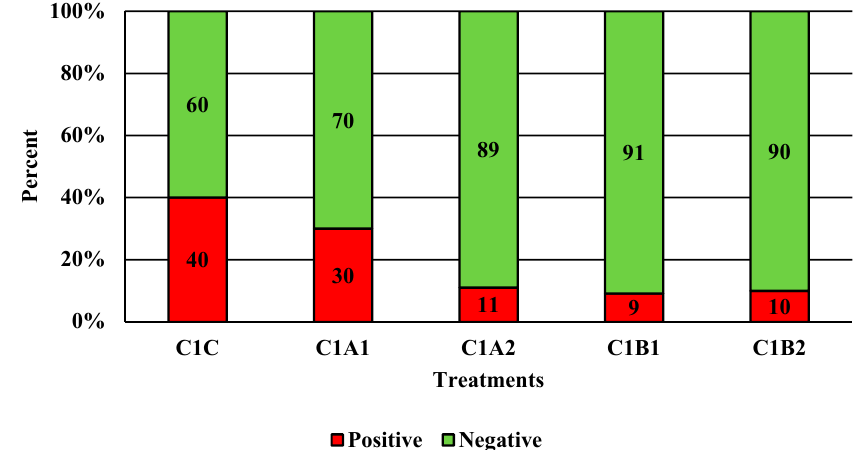
Figure 5. The effect of Competitor 1, a PAA sanitizer used as an antimicrobial dip (400 or 600 ppm) and in a stationary chilling tank (25 or 45 ppm) on the prevalence of Campylobacter present in the rinsates of 42-d-old Ross 708 broilers. N = 50, n = 10, p = 0.0013. CA1 refers to a 400 ppm/25 ppm treatment, CA2 refers to a 400 ppm/45 ppm treatment, CB1 refers to a 600 ppm/25 ppm treatment, and CB2 refers to a 600 ppm/45 ppm treatment, with each treatment being first a post-evisceration dip followed by an immersion chill.